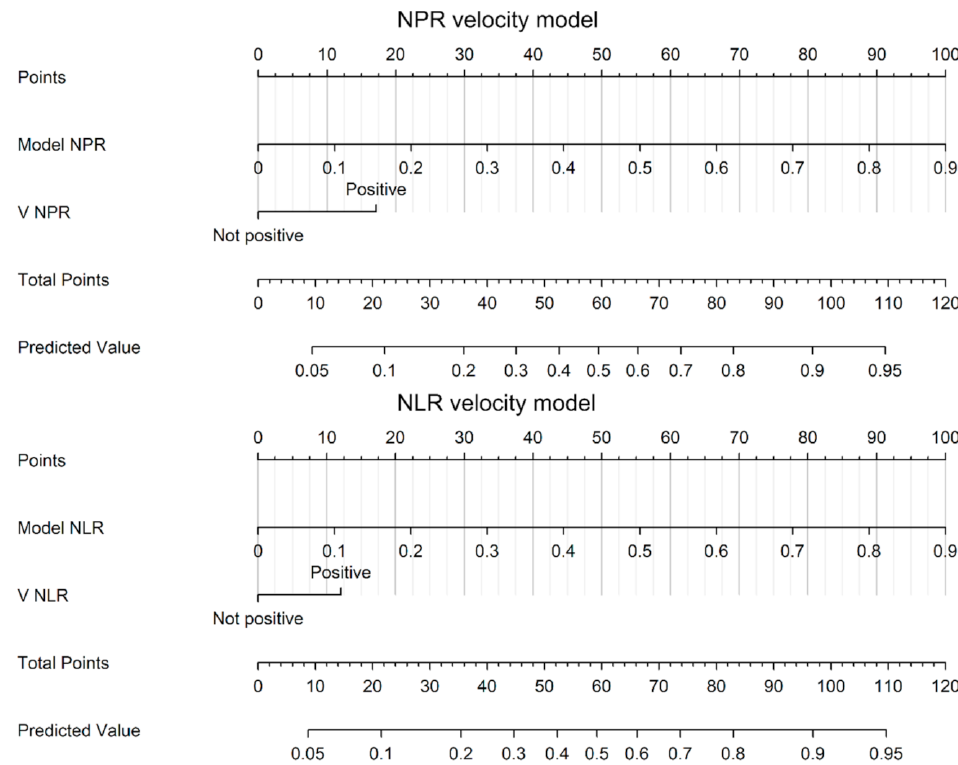
Figure 3. Nomograms of the NPR and NLR velocity models. Abbreviations: NLR, neutrophil- lymphocyte ratio; NPR, neutrophil-platelets ratio; VNLR, velocity neutrophil-lymphocyte ratio; VNPR; velocity neutrophil-platelets ratio; VNLR and VNPR categorized as positive